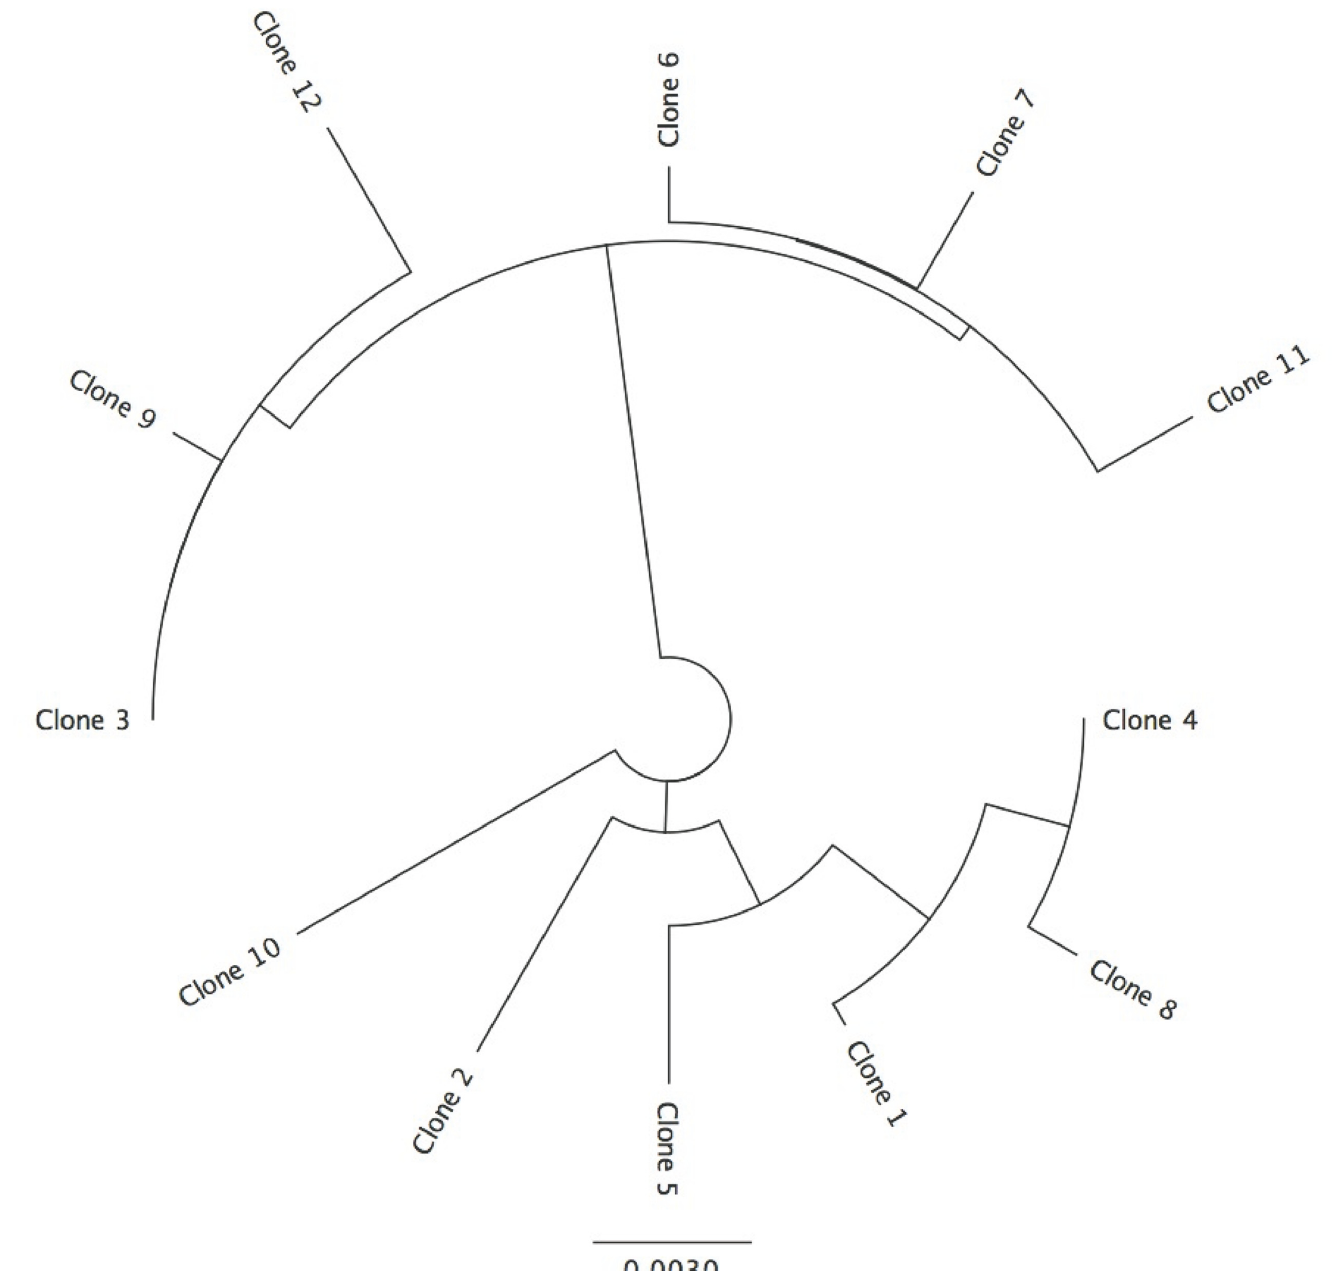
Fig 5. Thomomydoecus minor Clone Similarity. Neighbor-joining tree showing similarity between clones (numbered 1 – 12) derived from the DNA of a single individual of T . minor . Scale represents substitutions per site.